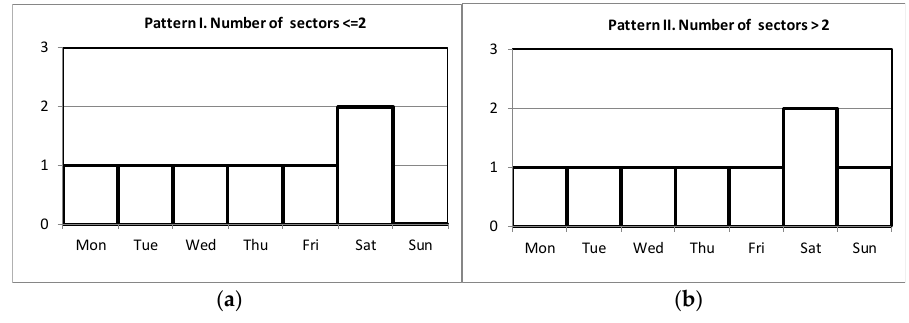
Figure 9. Weekly trend of irrigation pattern according to the number of sectors in the plot areas. 2.